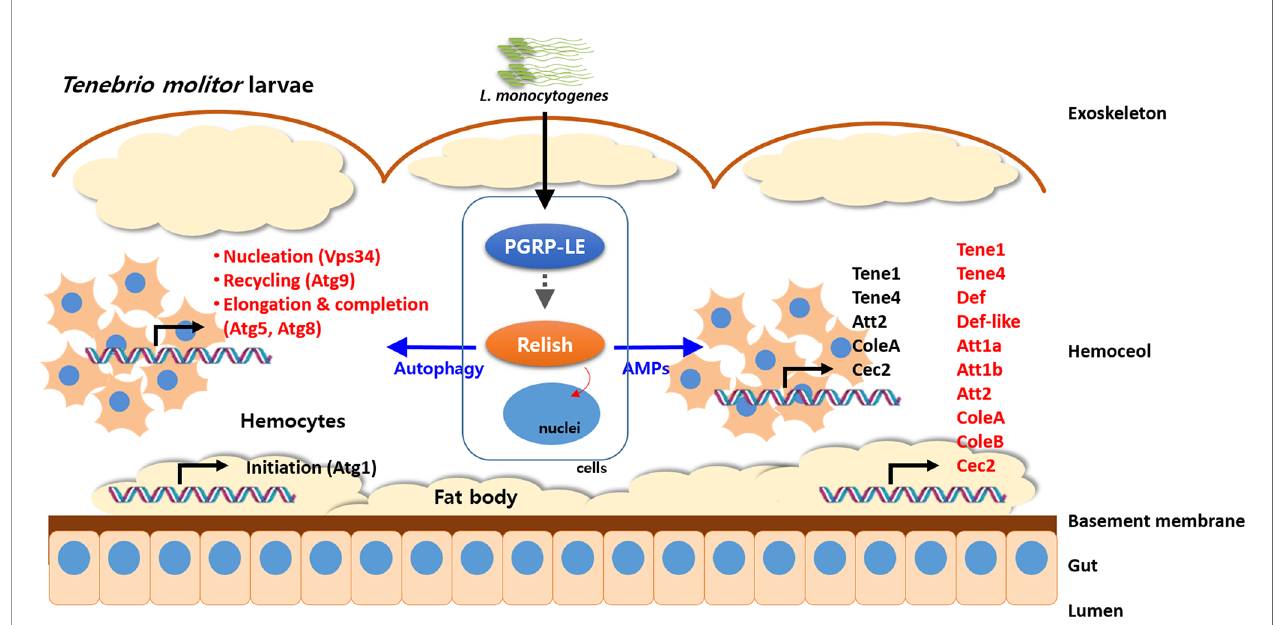
FIGURE 4 | Schematic illustration depicting cross-talk of autophagy process and NF- k B (Relish) pathway in response to pathogens in T. molitor . The intracellular Gram-positive bacterium, Listeria monocytogenes is recognized by PGRP-LE and the signaling cascade activates the NF- k B transcription factor, Relish. Subsequently, Relish regulates activation of autophagy by direct or indirect stimulation of nucleation step in hemocytes and AMP production in fat body. In addition, the Atg genes related to the nucleation ( TmVPS34 ), recycling ( TmAtg9 ), and elongation and recycling ( TmAtg5 and TmAtg8 ) were signi fi cantly regulated by silencing of TmRelish in